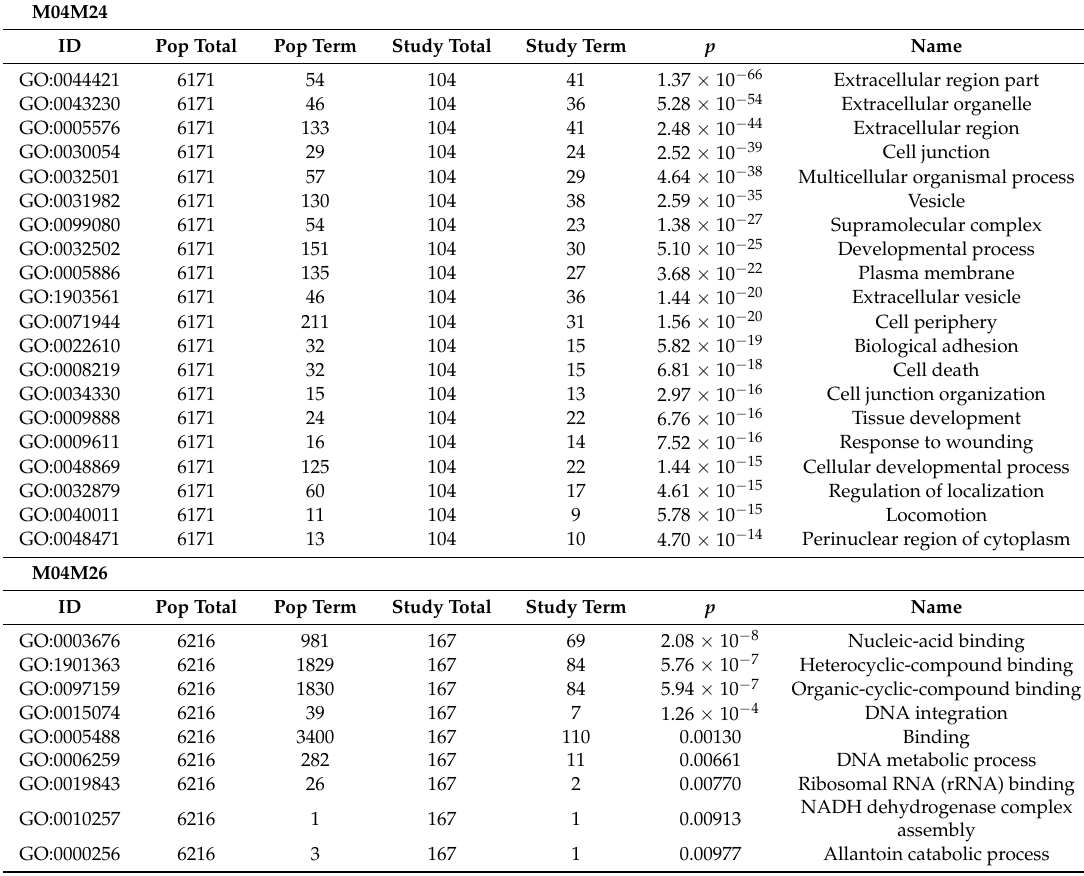
Table 3. The main GO enrichment results of endemic genes in the two opposite-polarity monospore of Morchella importuna . Pop—population;